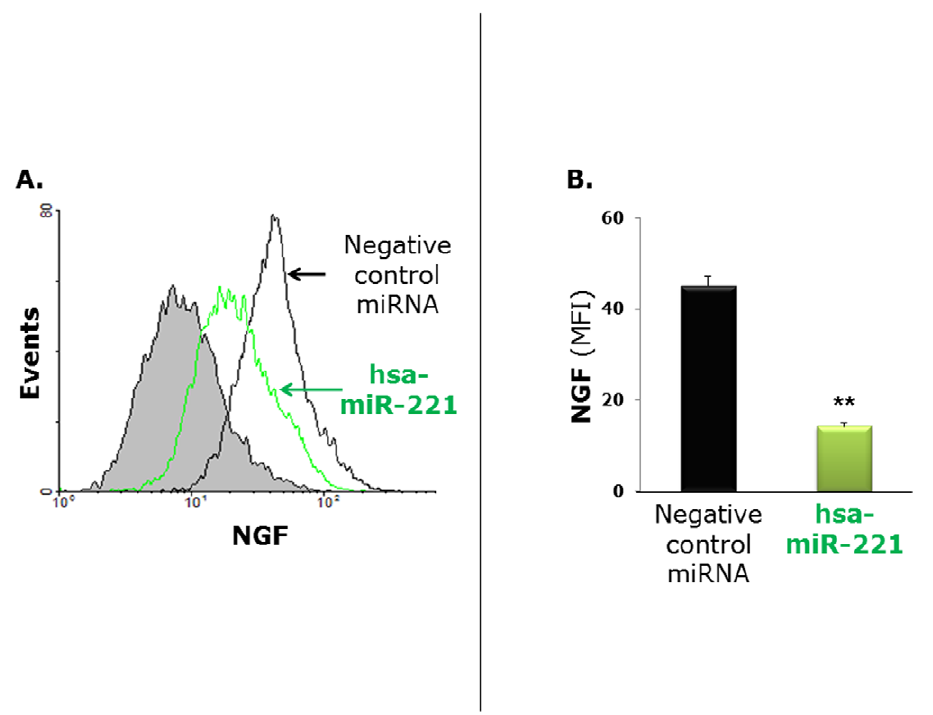
Figure 5. Combined effect of miR-221 and RSV on NGF expression. (A) Flow cytometry analysis of hsa-miR-221-overexpressing bronchial epithelial cells 24 h after infection with rgRSV showed significantly lower expression of NGF protein compared to infected cells with normal miR-221 expression. The gray population represents the isotype control. (B) Geometric mean fluorescent intensity (MFI) was averaged from the flow cytometry measurements obtained in 3 or 4 independent experiments. Data are expressed as the mean 6 SEM. *=p , 0.01 compared to cells transfected with the negative control miRNA.